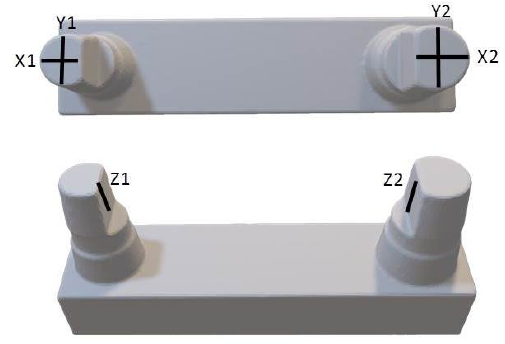
Figure 4. Course of the traversing lengths and measurement directions.